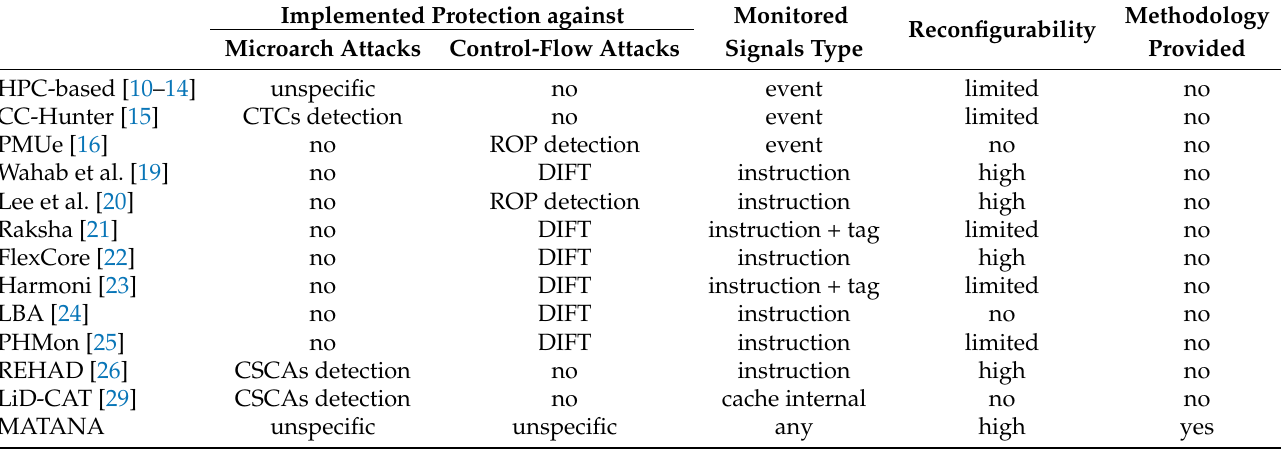
Table 1. Comparison of different attack detection systems based on the analysis of microarchitectural signals. Reconfigurability is classified high if some reconfigurable fabric is used, limited if some configuration bits that change the hardware’s behavior exist, and no if the reconfigurability is not possible or not discussed. Note: CTC = Covert Timing Channel, CSCA = Cache Side-Channel Attack, ROP = Return-Oriented Programming, DIFT = Dynamic Information Flow